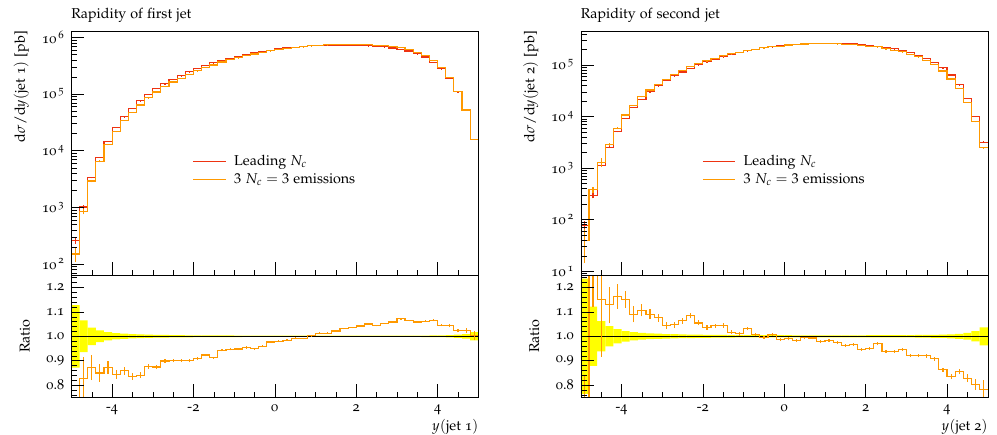
Figure 6 . Rapidity distribution of the hardest and second hardest jet while considering only qg qg !